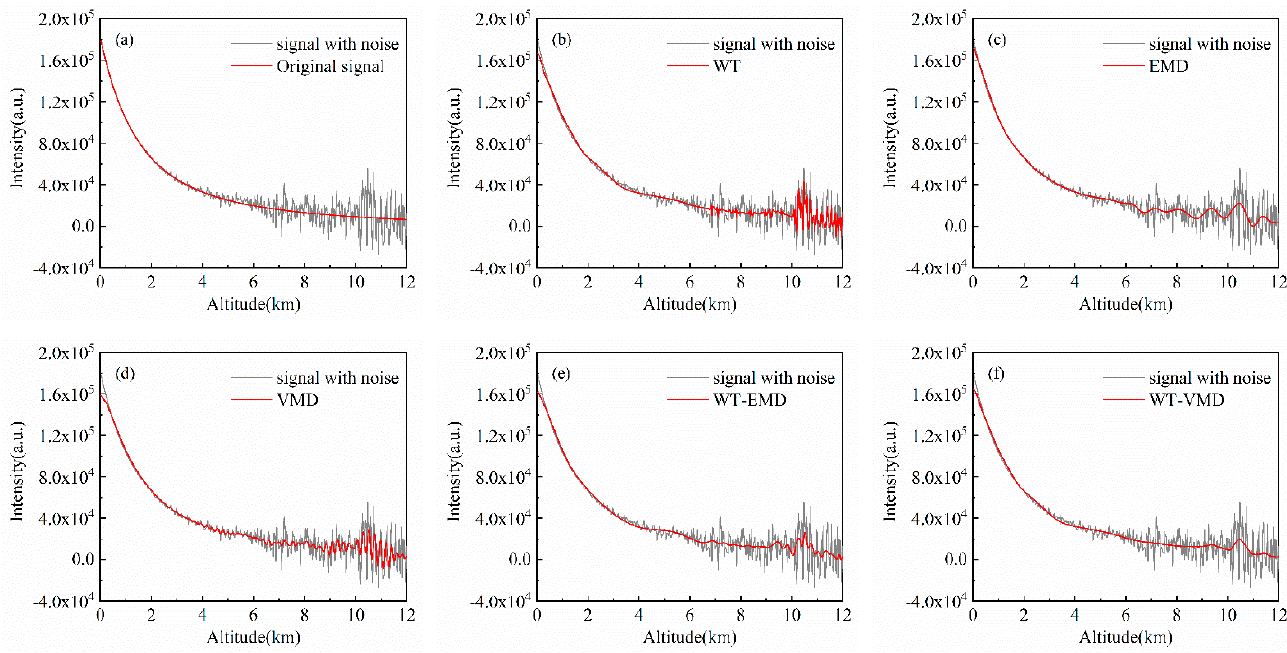
Table 1. evaluation Index of 50-pulse cumulative signal (no pollution) after denoising.